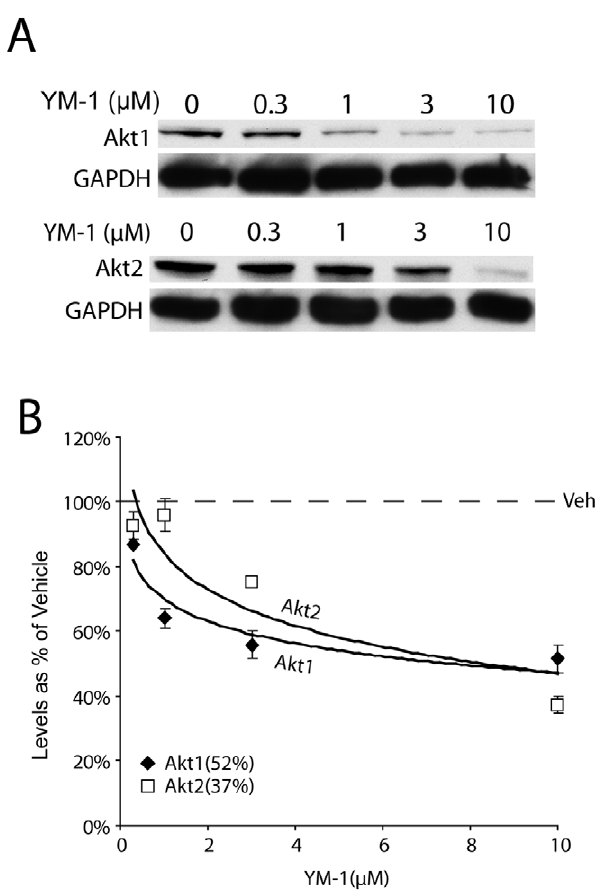
Figure 6. Akt isoforms are concentration dependently reduced by YM-1, potential mechanism for resistance phenomena. MCF7 cells were treated with noted concentrations of YM-1 for 6 hours. Cells lysates were analyzed by Western blot (A). Densitometry analysis of Akt-1 and Akt2 levels shown as % of vehicle treatment 6 SD (B).